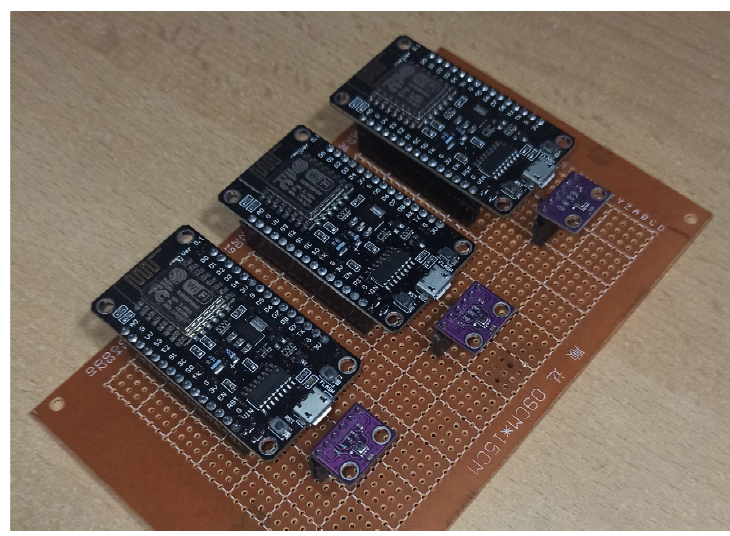
Figure 7. ESP8266 and BME280, own study A. Wycisk.